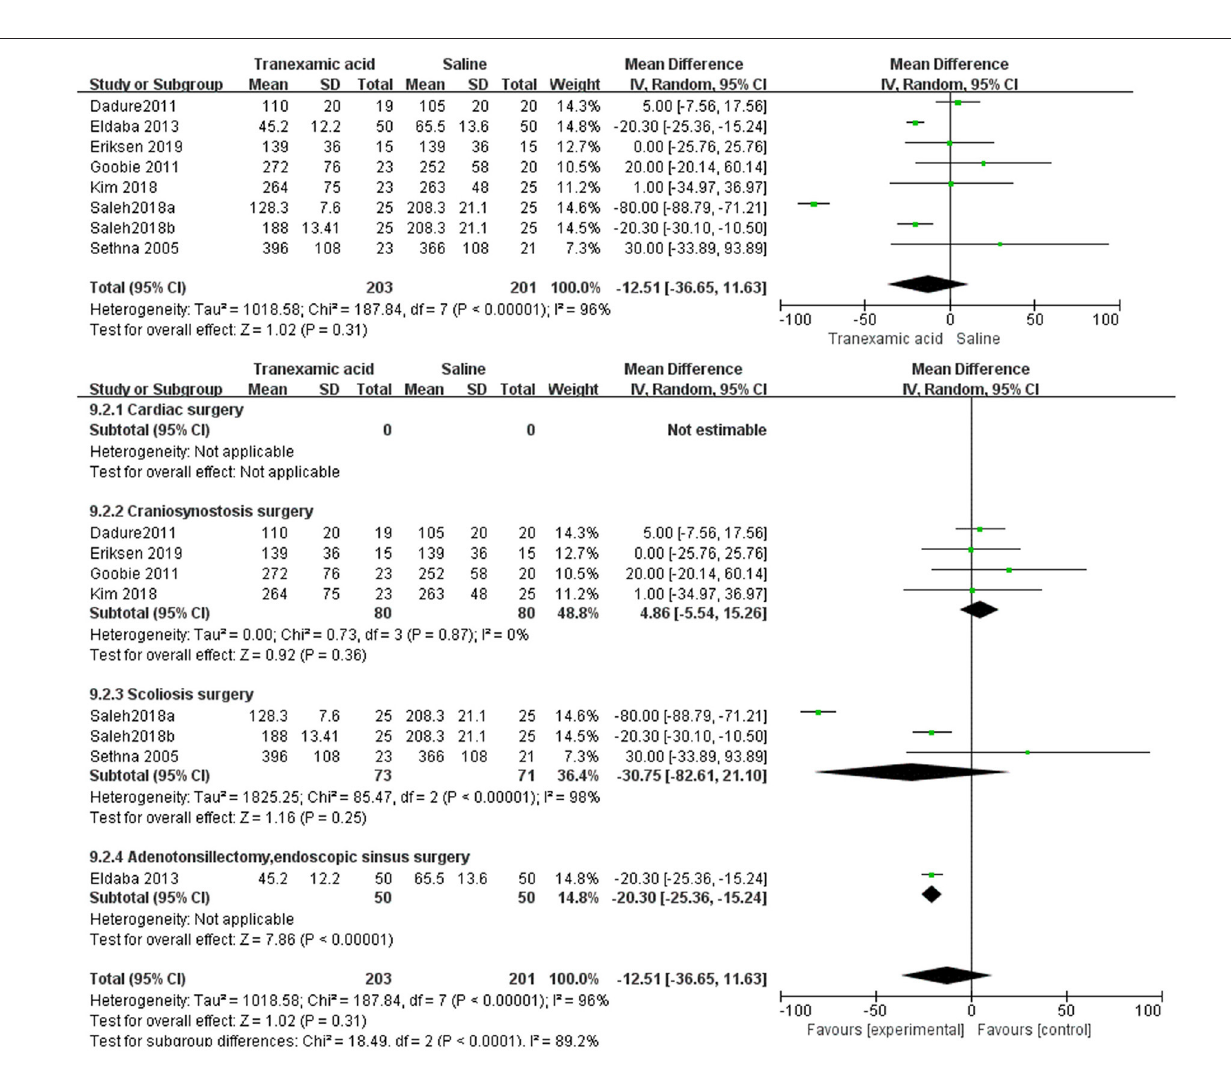
Frontiers in Surgery |